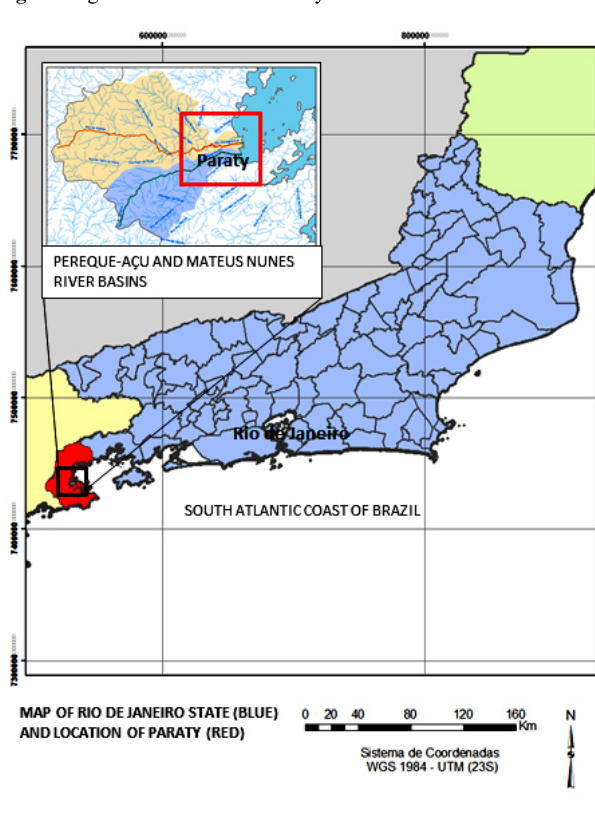
Fig. 1 . Regional location of Paraty.